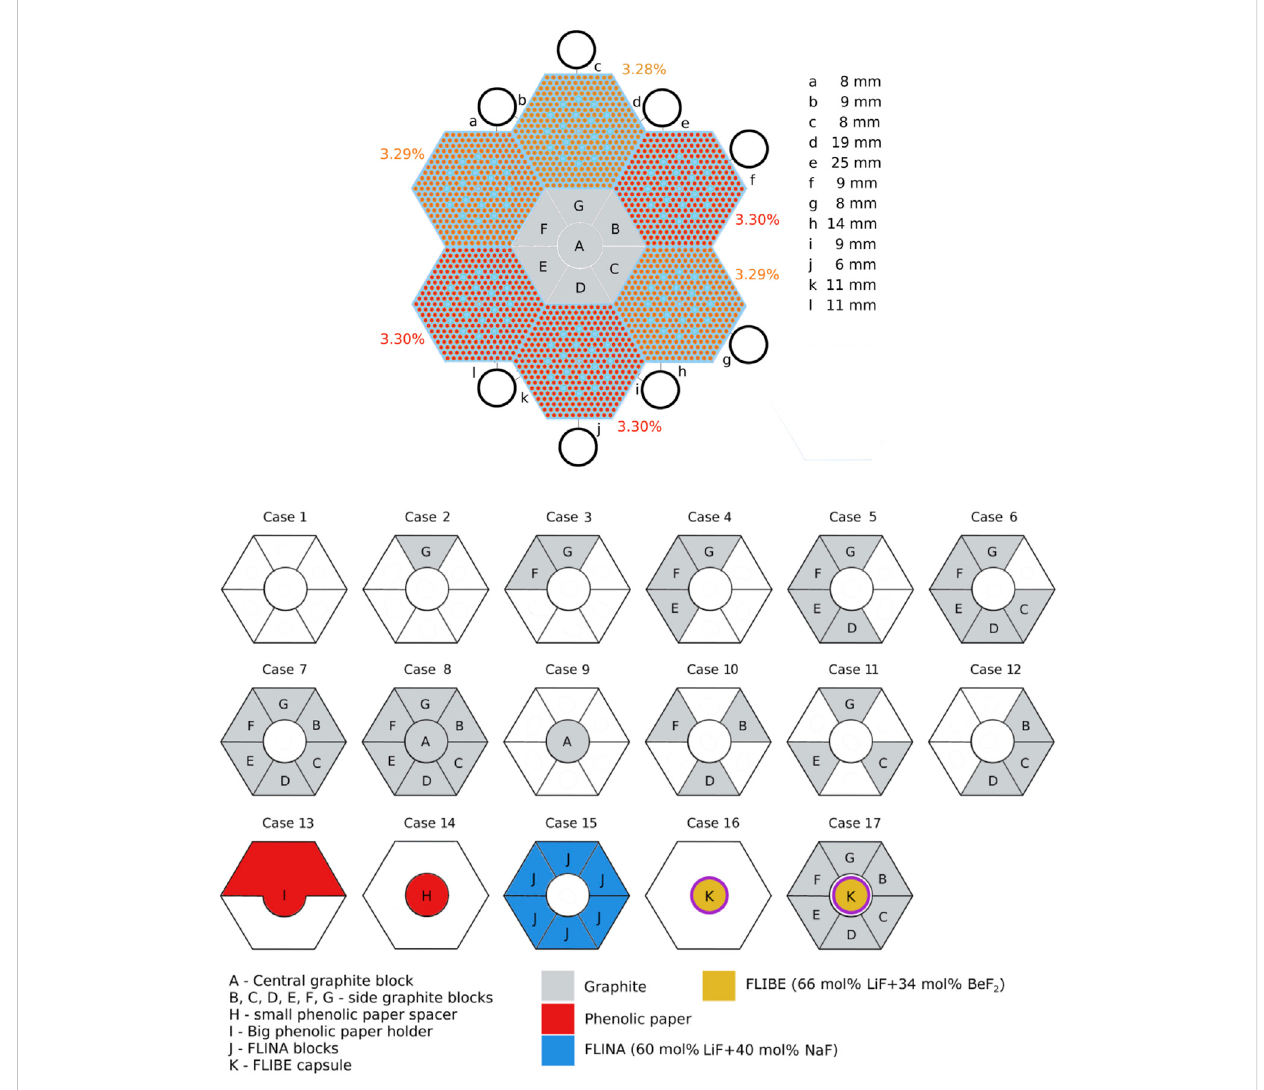
Schematic of the VVER core loading (Top) with various arrangements of central module testing materials